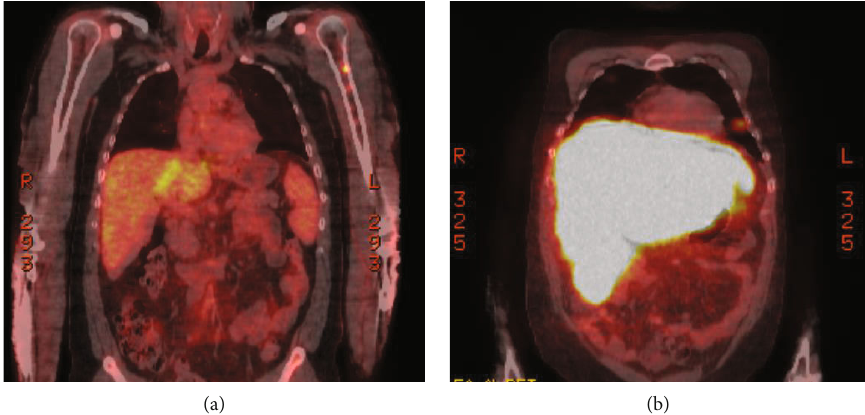
Figure 2: PET/CT scan of the abdomen. (a) One month prior to the fi rst cycle of nivolumab: multiple intrahepatic lesions. (b) Day 22 after the fi rst cycle of nivolumab: signi fi cant hepatomegaly due to hepatitis, signi fi cant increased metabolic activity of the entire liver, and new abdominal ascites. The PET/CT scan of the patient abdomen depicts the changes in the patient ’ s liver before and after starting nivolumab. The second picture shows the large size of the liver when the patient developed autoimmune